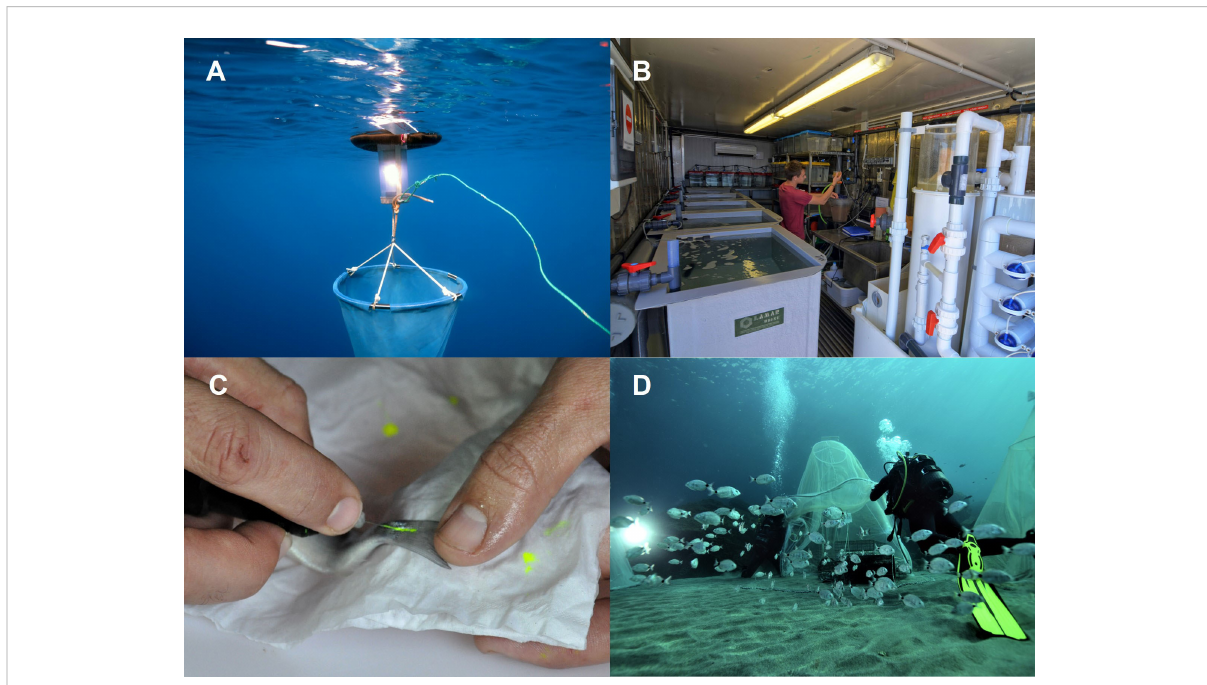
FIGURE 2 (A) Capture of wild post-larvae with light traps; (B) culture of wild-caught post-larvae in aquaria; (C) pre-release tagging with elastomer implant at the base of the tail fi n; (D) staggered release of juveniles using tents for initial acclimation to enhance survival rates. Photos: © Re ́ my